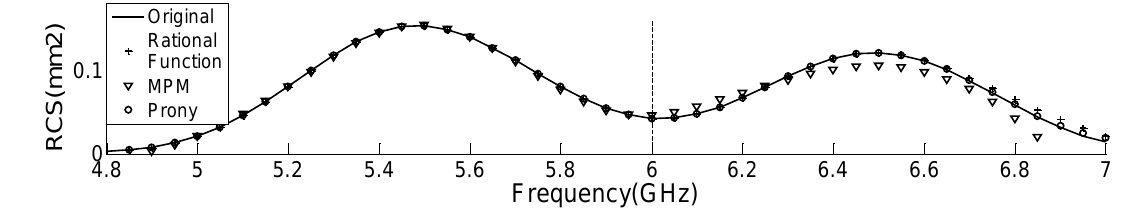
Figure 3. Jet Plane RCS prediction results at 21 deg.